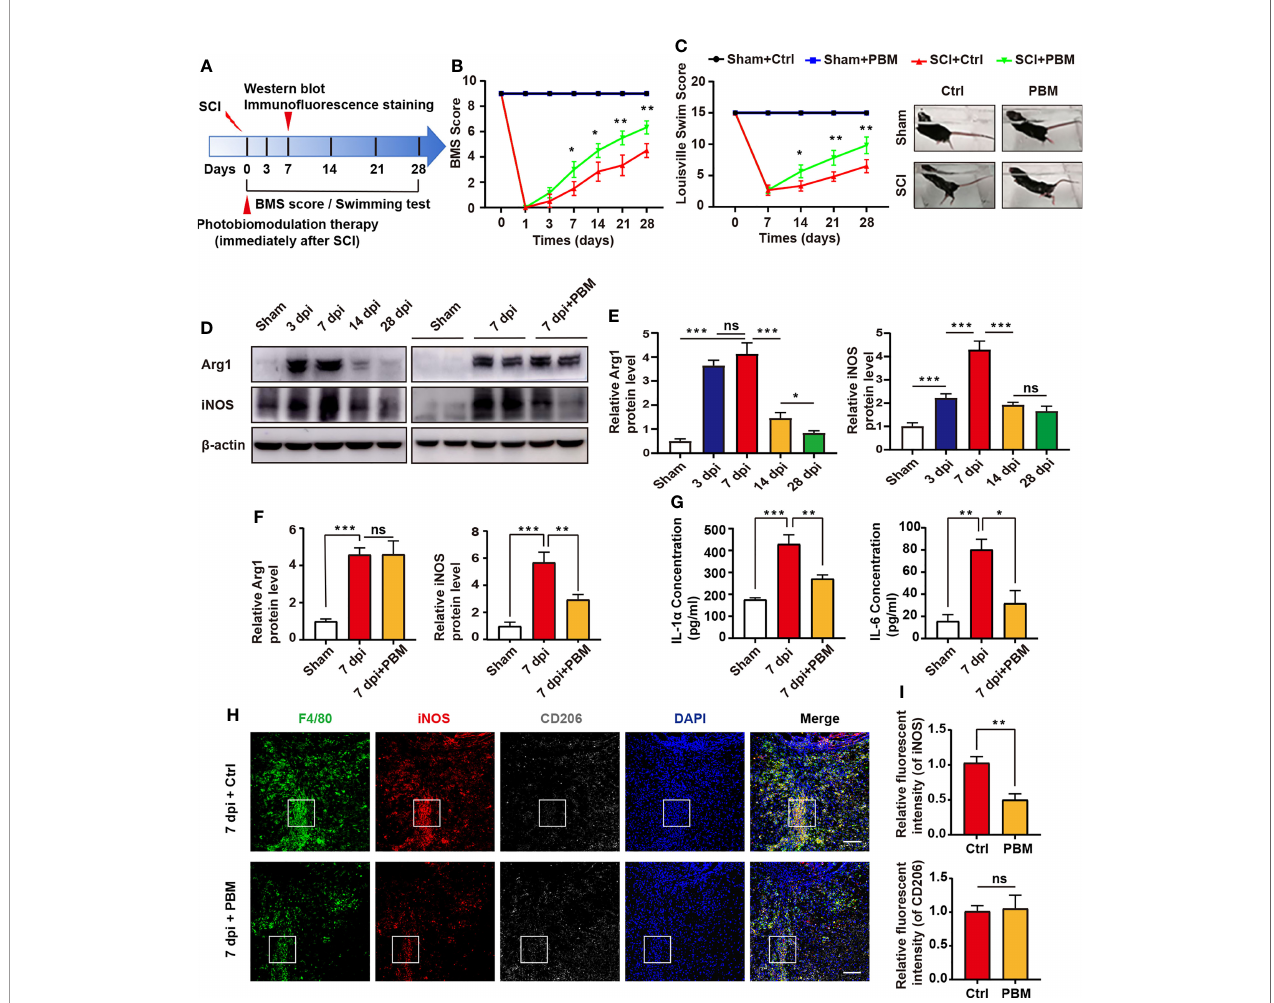
FIGURE 1 | PBM promotes the recovery of motor function in mice with compressive SCI and reduces the neurotoxic polarization of macrophages in the injury area. (A) Experimental paradigm. (B) Statistical analysis of the Basso Mouse Scale (BMS) score in the sham surgery and SCI groups over a period of 28 days (n = 6 mice per group at each time point). (C) Photographs of varying degrees of trunk instability observed after SCI or sham surgery and statistical analysis of the Louisville Swimming Scale (LSS) over 28 days in the control and PBM groups (n = 6 mice per group at each time point). (D – F) Immunoblotting of Arg1 (M2 macrophage marker) and iNOS (M1 macrophage marker) at 3 dpi, 7 dpi, 14 dpi, and 28 dpi or after sham surgery (28 days after the sham operation) (n = 3 mice per group at each time point). (G) ELISA results for IL-1 a and IL-6 in the injured spinal cords of each group at 7 dpi. (H, I) Representative immunohistochemical staining of F4/80 (macrophage marker), iNOS (M1 macrophage marker) and CD206 (M2 macrophage marker) in the epicentre of the injured spinal cord of the control and PBM groups at 7 dpi (scale bar = 100 m m). *P < 0.05, **P < 0.01, ***P < 0.001; ns, not signi fi